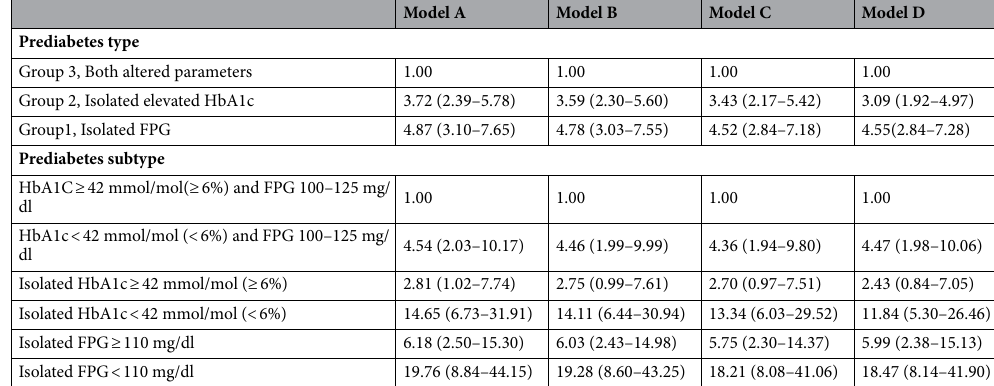
Table 3. Reversion to normal glucose regulation. Odds ratio (and 95% confidence interval) according prediabetes type and according prediabetes subtype. Model A: Adjusted by sex and age. Model B: Model A plus hypertension, hypercholesterolemia, HDL levels and Triglycerides. Model C: Model B plus alcohol consumption, smoking, BMI, abdominal obesity, physical activity, adherence to Mediterranean diet. All variables were considered and treated as categorical variable. Model D: Model A plus alcohol consumption, smoking, BMI, abdominal obesity, physical activity, adherence to Mediterranean diet plus hypertension and all the